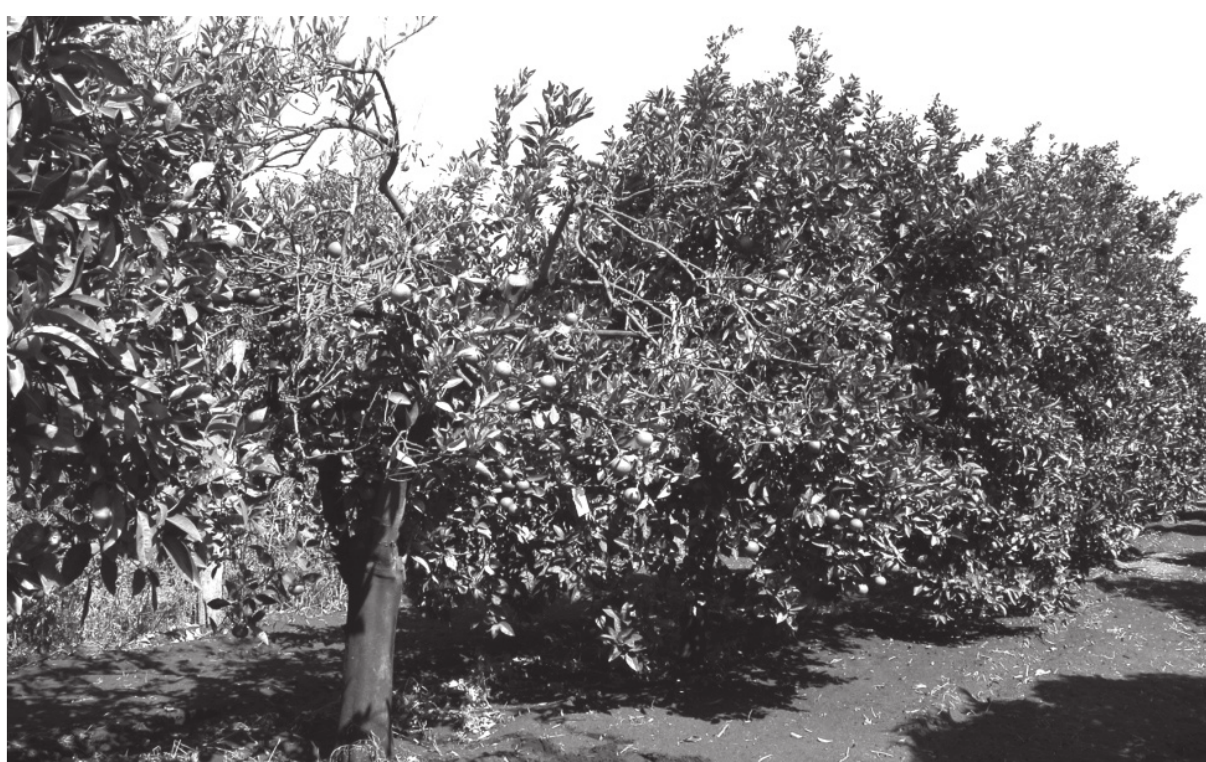
Figure 3. Severe decline of sweet orange ‘Washington navel’ grafted on sour orange (in front) in comparison with healthy plants (at the